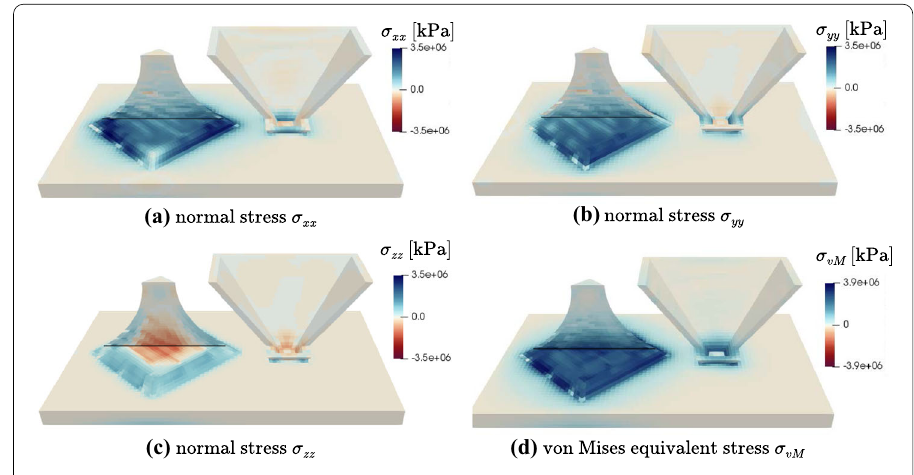
Fig. 24 Two pyramids example: stress distribution in pyramids after final cooldown. Normal stresses a σ xx , b σ yy , c σ zz , and d von Mises equivalent stress σ vM . Part of the geometry is cut out above first powder layer and at y = 0 . 6mm for visualization of stress inside the pyramid